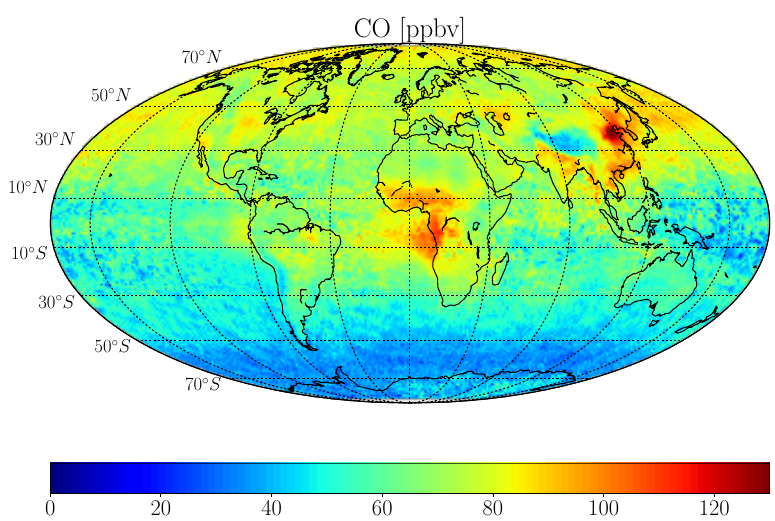
Figure 16. Dry air CO column-averaged mixing ratios in ppbv over land and the oceans. The values are averaged from January 2003 to December 2011 on a [1 of clear-sky scenes and optically thick cloud conditions are included.